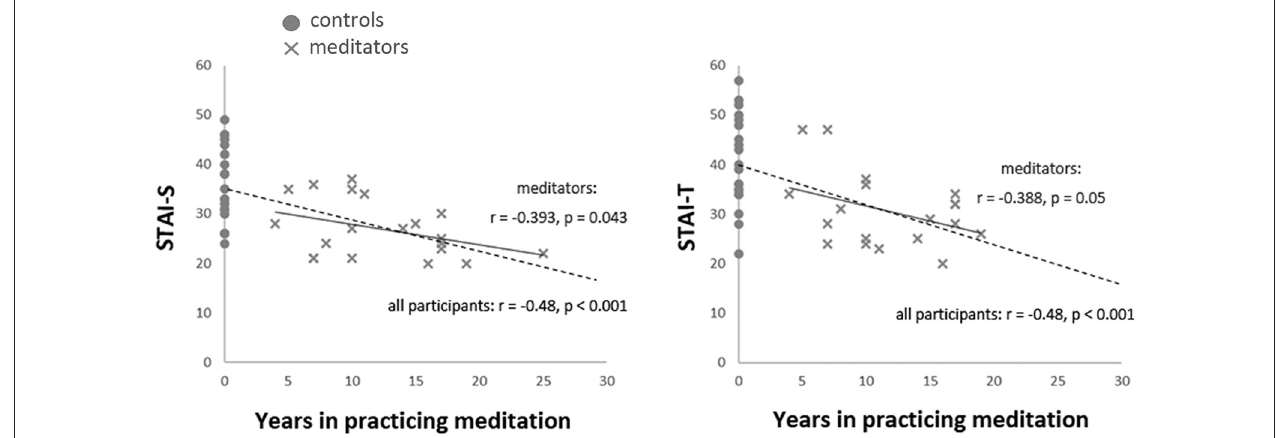
FIGURE 1 | Correlation between the years of meditation experience and anxiety. The years of meditation experience were negatively correlated with the scores of State-Trait Anxiety Inventory (STAI) across all participants (STAI-S: r ( 41 ) = − 0.48, p = 0.001; STAI-T: r ( 41 ) = − 0.48, p = 0.001, dash line) and among meditators (STAI-S: r ( 20 ) = − 0.393, p = 0.043, one-tailed; STAI-T: r ( 20 ) = − 0.388, p = 0.05, one-tailed, solid line).